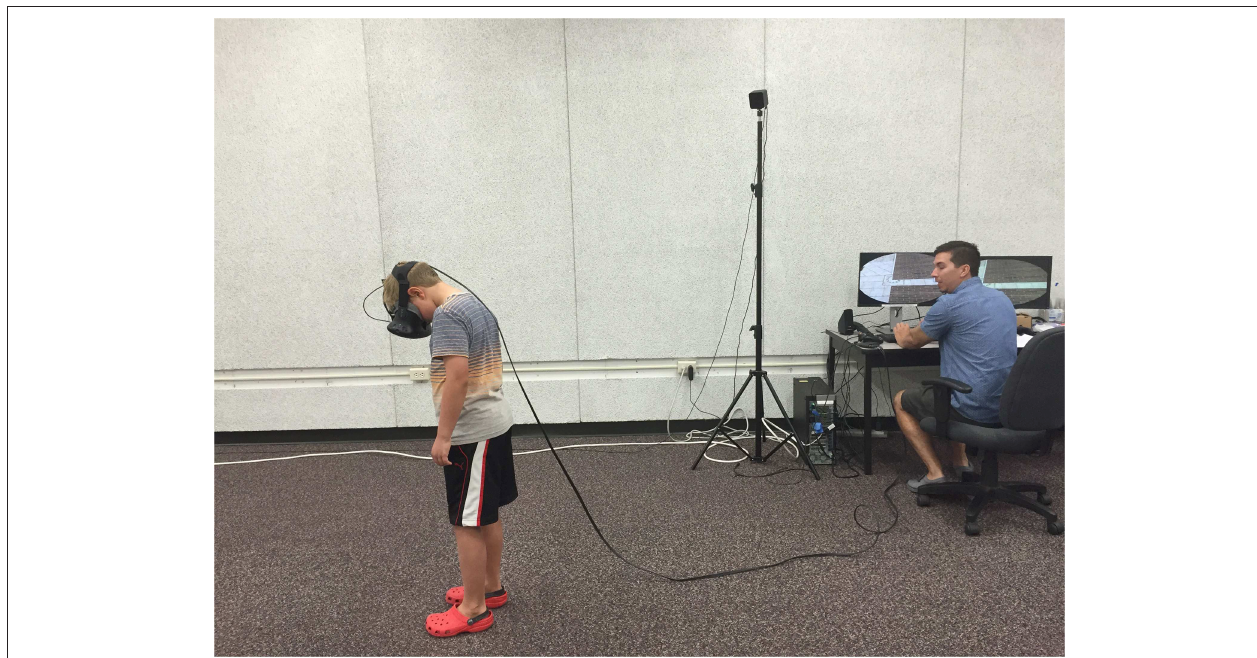
FIGURE 1 | Child participant viewing the gap. Written informed consent was obtained from the individuals portrayed in this image.